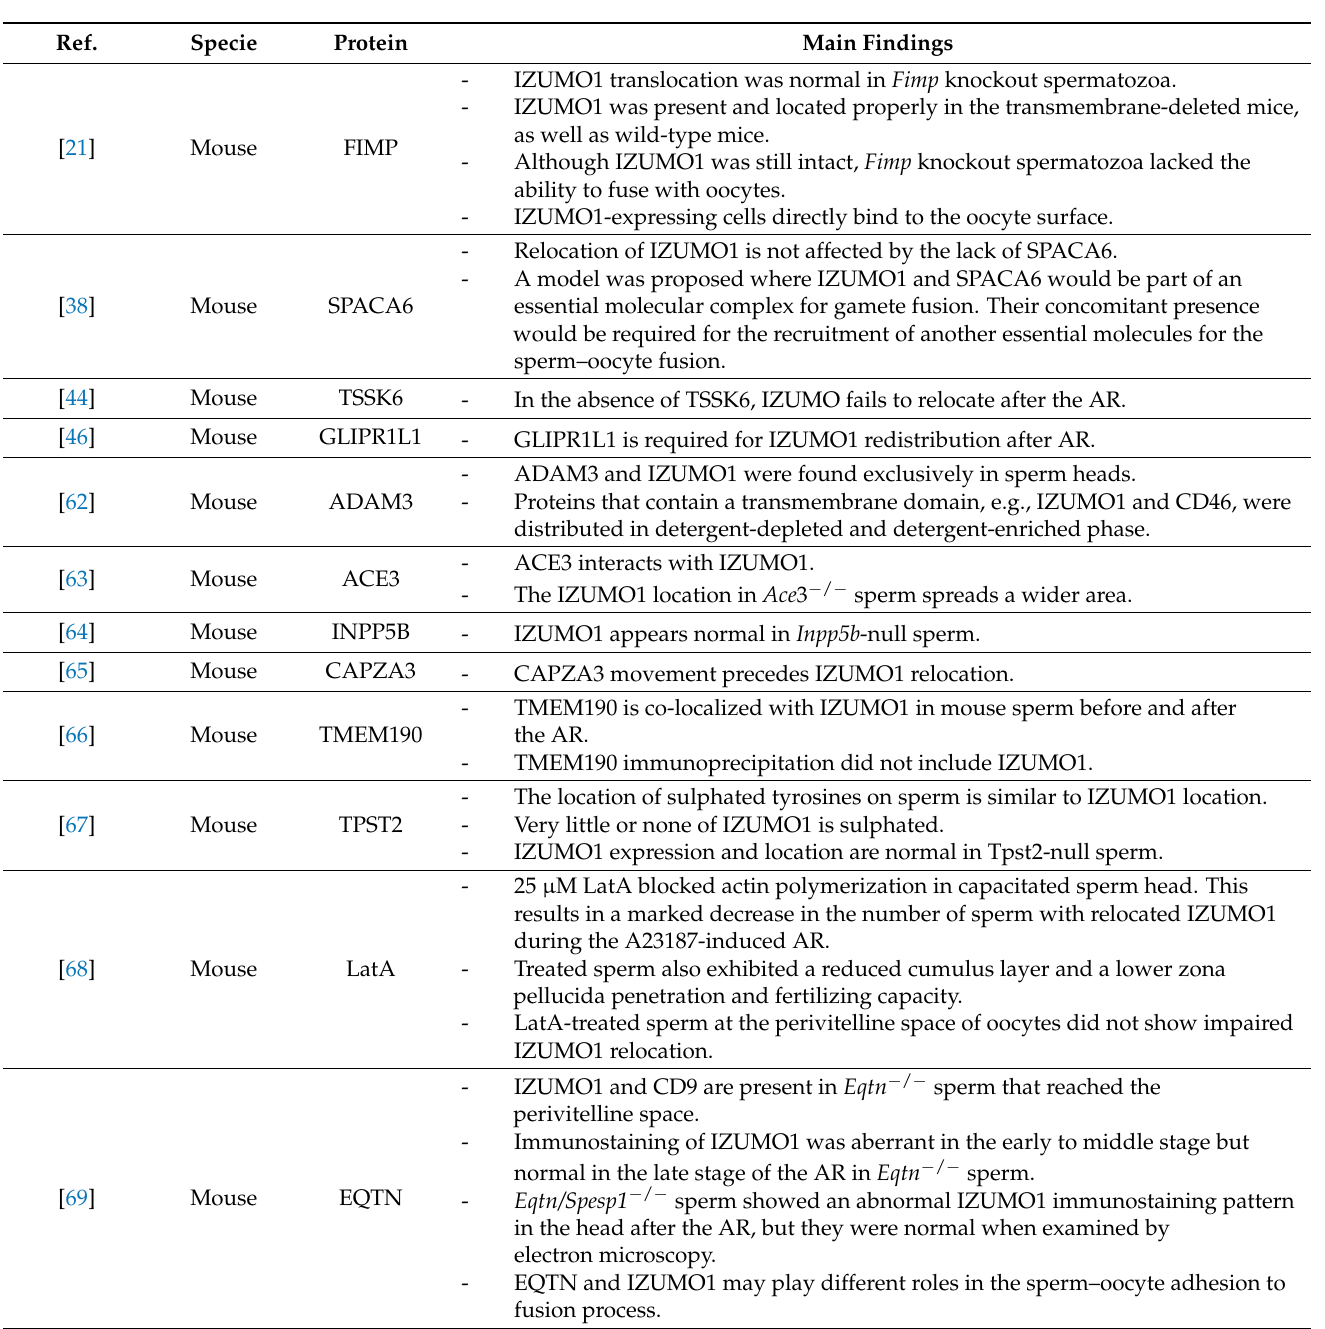
Table 2. Articles studying the relationship between IZUMO1 and other proteins. Main